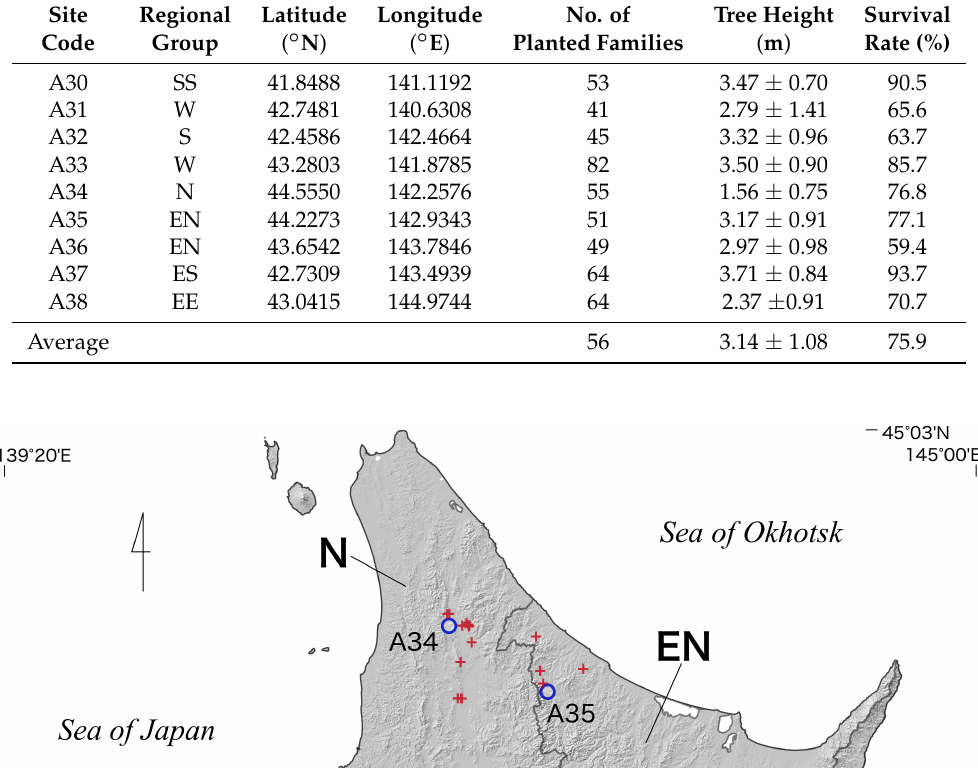
Table 1. Summary of provenance tests for A. sachalinensis . The values for tree height and survival rate at 10 years after planting.